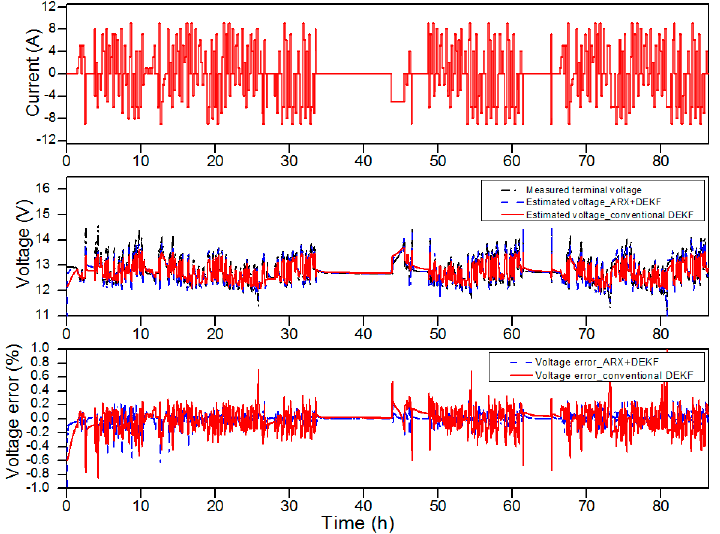
Figure 10. Comparison of the voltage estimation for the aged battery (59.3% SOH) by the proposed ARX-DEKF and conventional DEKF method.